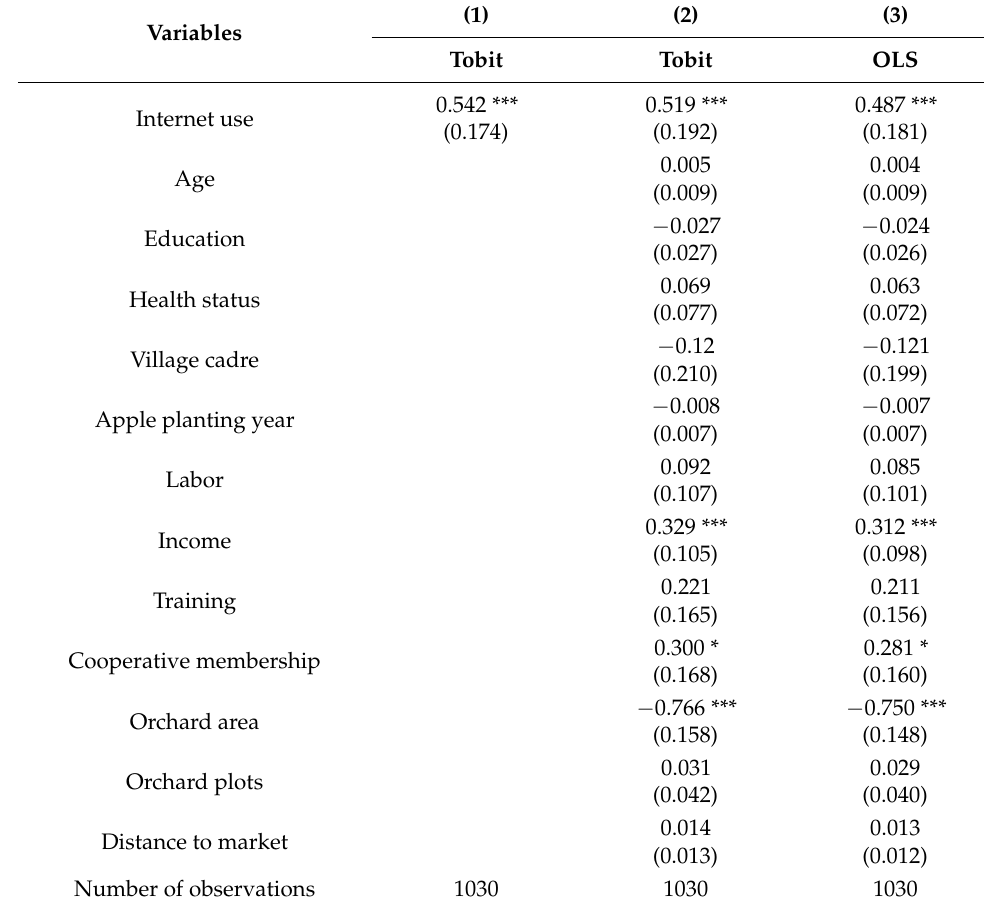
Table 2. Estimated results of internet use on farmers’ organic fertilizer investment.